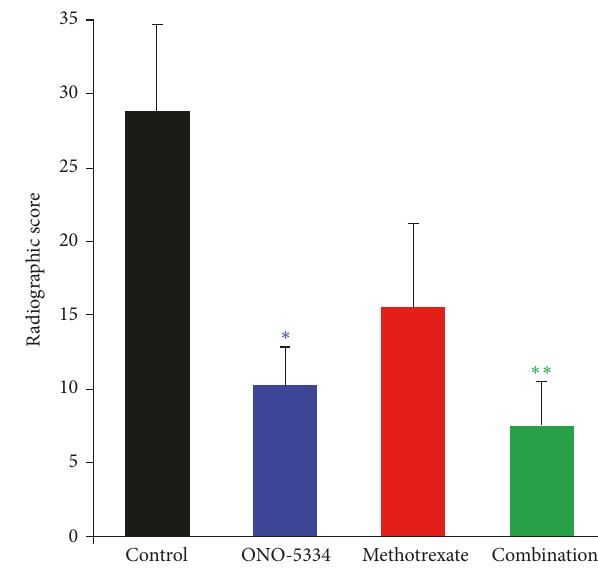
Figure 2: X-ray examination of total affected joint number (DIP, PIP, and MP joints in the second, third, fourth, and fifth digits of the forelimbs and hindlimbs: total 48 joints/monkey) in collagen- induced arthritis monkeys. Data are expressed as mean ± SE of con- trol (n=8), ONO-5334 (n=9), methotrexate (n=8), and combination (n=9) groups. ∗ p < 0.05 and ∗∗ p < 0.01 versus control group (Tukey